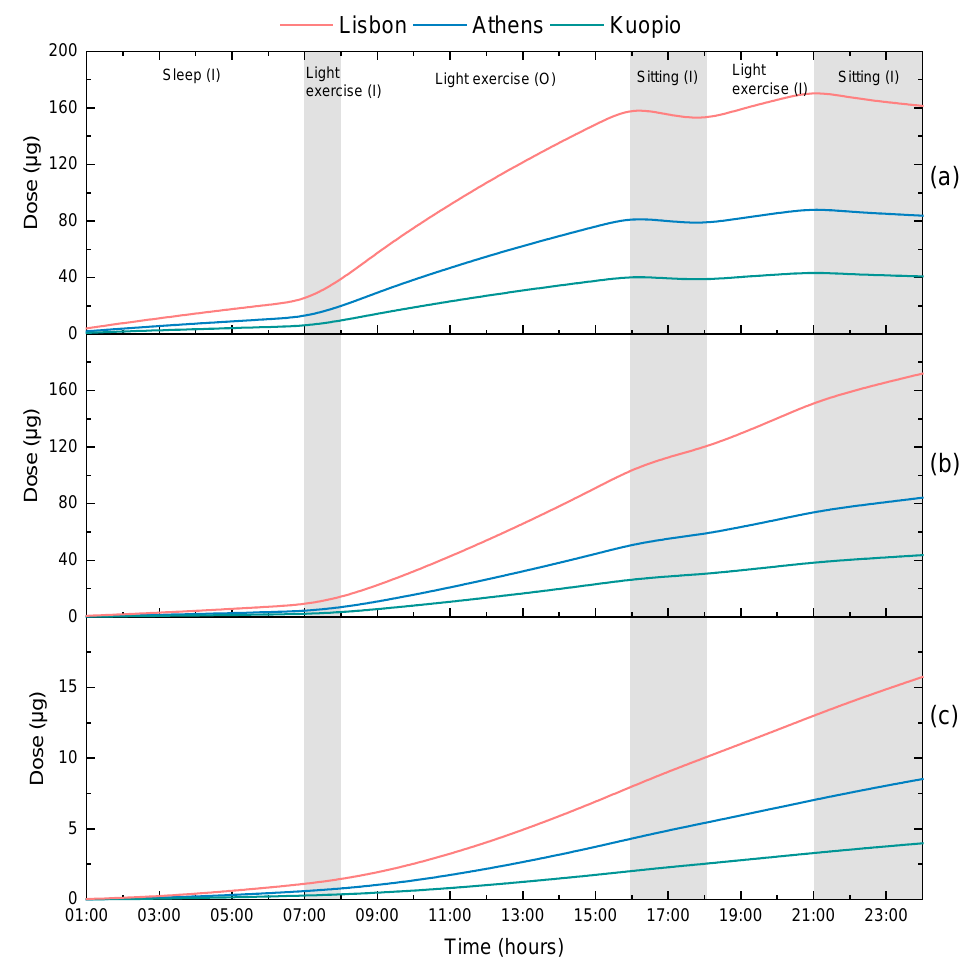
Figure 3. Cumulative dose (μg) of inhaled particulate matter in the ( a ) respiratory tract (retained dose), ( b ) Oesophagus and ( c ) blood for an adult male in the three cities. (I) represents indoors and (O) outdoors.